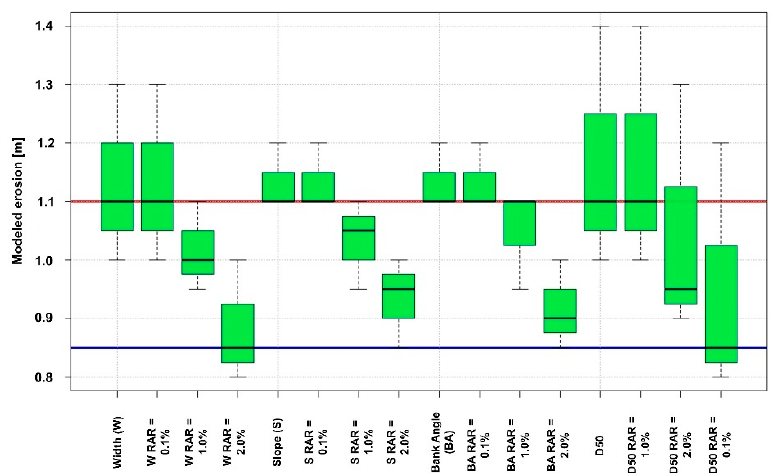
Figure 9. Sensitivity analysis for the Sulzigraben catchment for the first erosion event in 2012. For every input parameter, the value varied +/ − 10% from the original input value. The red line is the reference for the total modeled erosion = 1.10 m for the first event using the original input values without considering the e ff ects of roots. The blue line is the reference for the total modeled erosion = 0.85 m for the first event using the original input values considering the e ff ects of roots (left streambank). Each boxplot represents the quantile of the cumulative erosion.